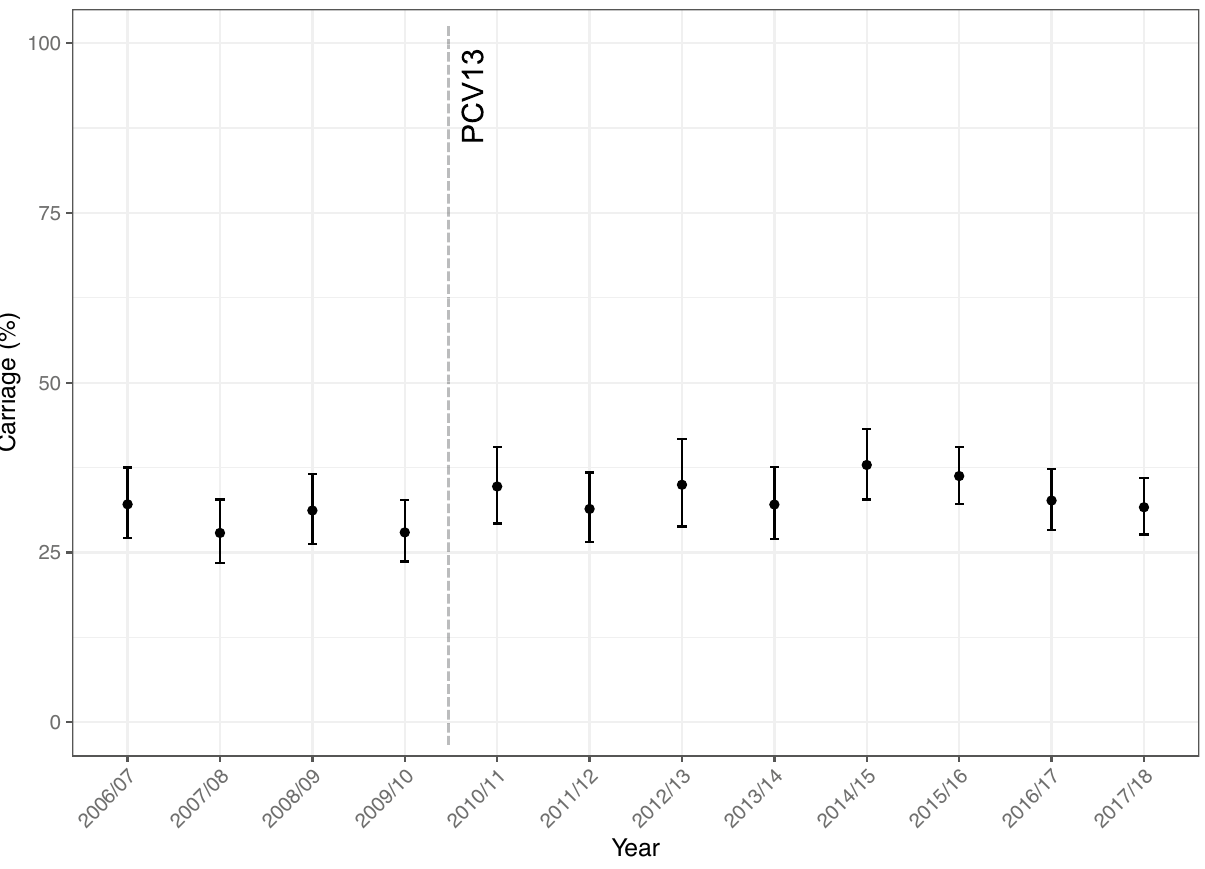
Figure 1. Carriage prevalence (%) of S. pneumoniae (all serotypes) in each year of the study. Overall carriage has remained consistent at an average of 32.5%, ranging from 27.8% in 2008/09 to 37.9% in 2014/15. Introduction of PCV13 is shown by the vertical line. Error bars represent 95%